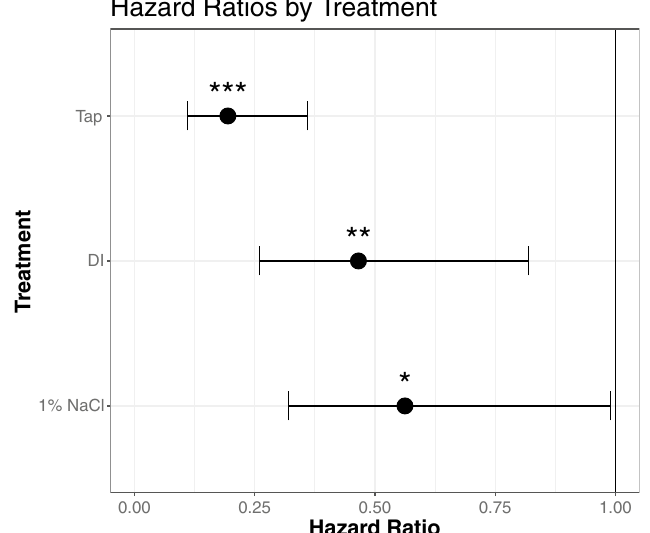
Figure 2. Cox Proportional Hazards Ratios for cages of bees given supplemental water (either tap water, deionized (DI) water, or a 1% NaCl solution in deionized water), and a control group offered no supplemental water. Whiskers represent the 95% confidence intervals, none of which cross the null hypothesis of HR = 1 (Vertical line) demonstrating the reduced hazard of water provisioning in any form. * α < 0.05, **α < 0.01, ***α < 0.001.